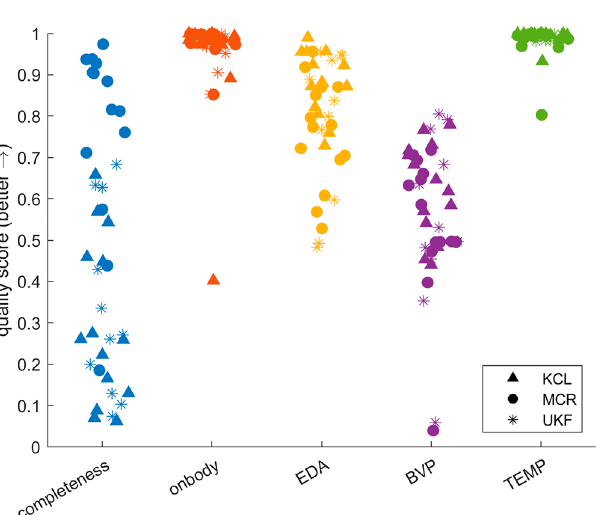
Figure 5. Swarm plot of the data quality score distributions for the outpatient cohorts (N =